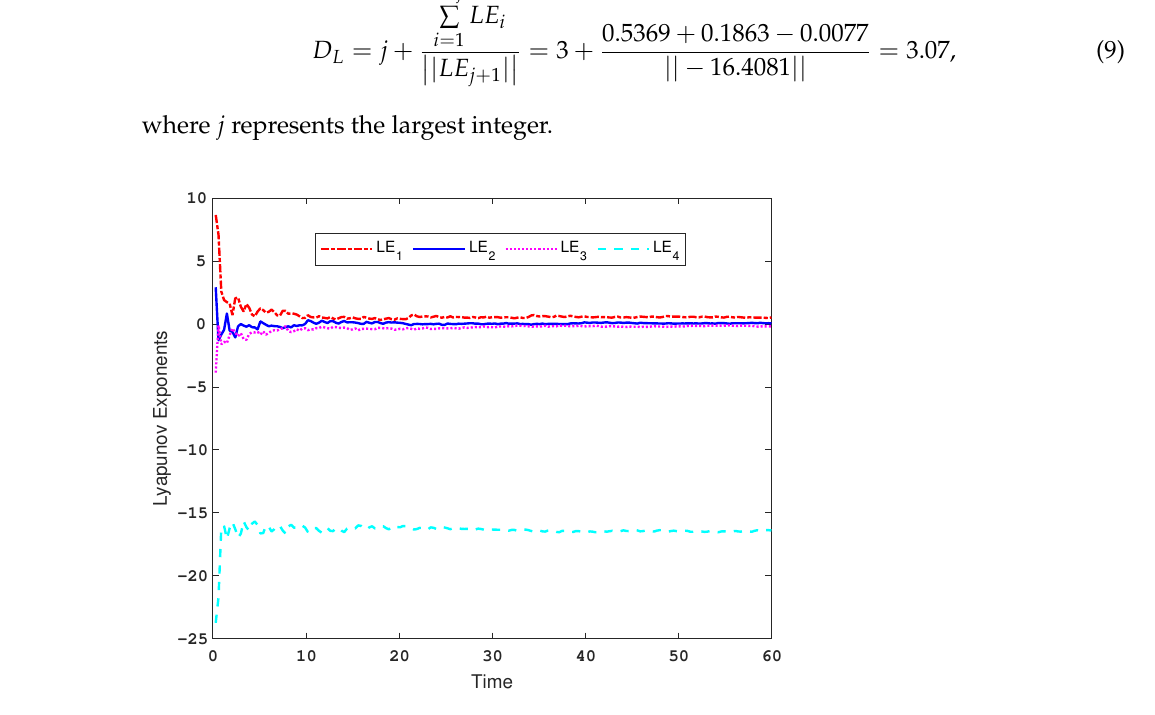
Figure 3. The Lyapunov exponential spectrum of the memristor-based hyper-chaotic Bao-like system with the initial condition x ( 0 ) = [ 10,10,10,10 ] T . Table 1. Lyapunov